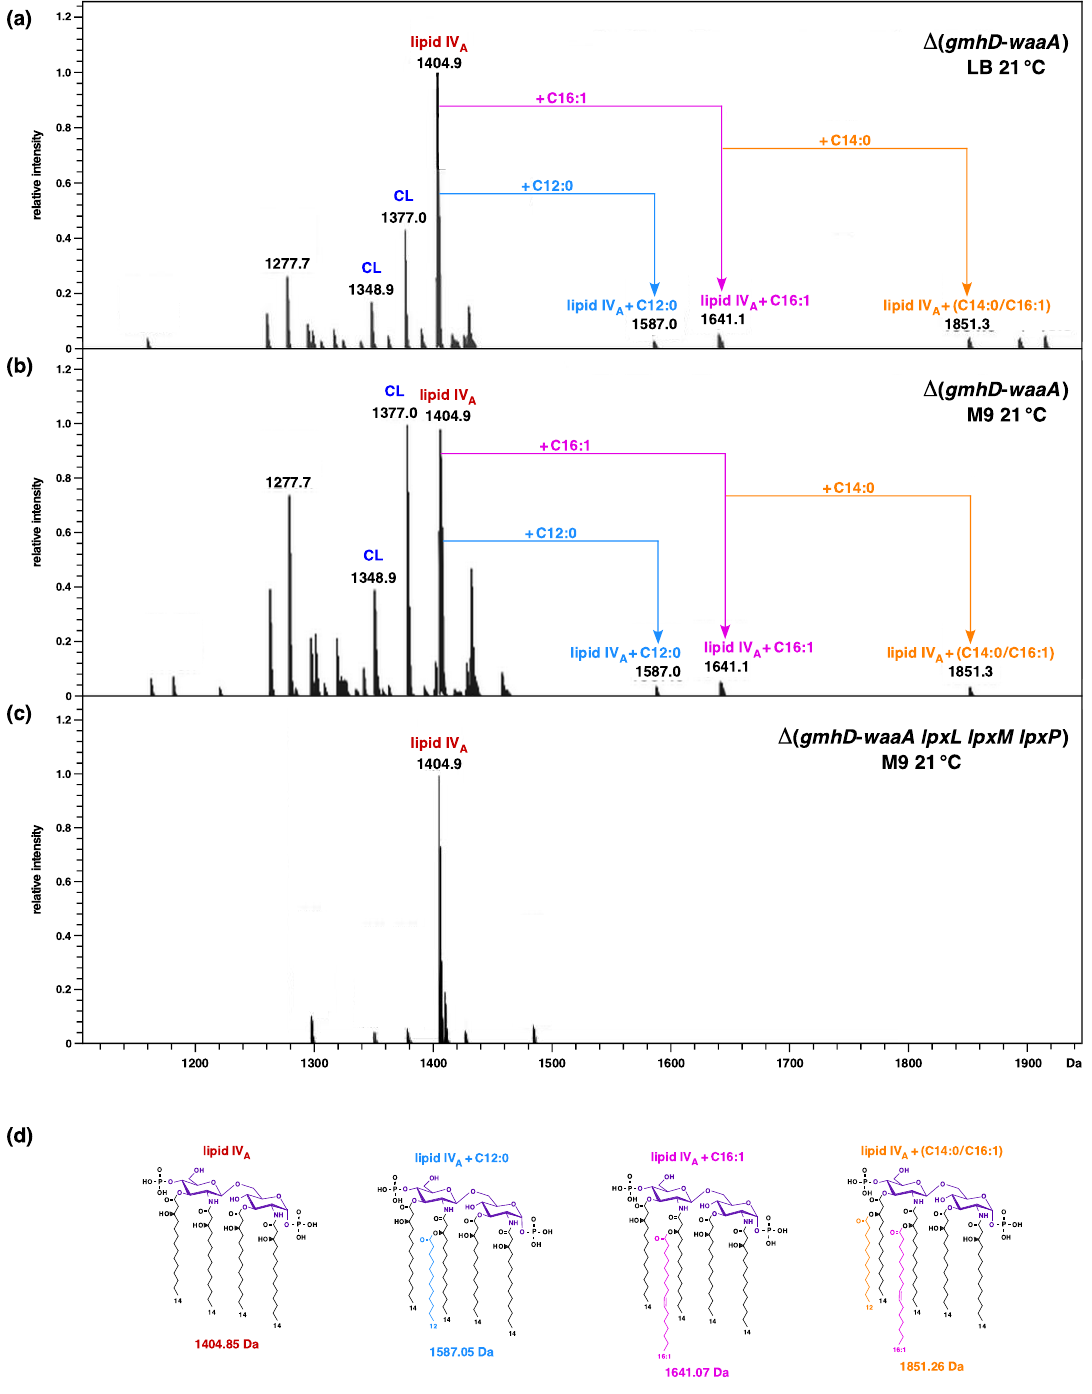
Figure 2. Charge deconvoluted ESI FT–ICR mass spectra in the negative ion mode of deletion derivatives of the whole waa locus, including WaaA Kdo transferase: ( a ) Mass spectra of LPS obtained from the Δ( gmhD–waaA ) strain grown in LB medium at 21 °C and ( b ) in M9 minimal medium. ( c ) Mass spectra of LPS obtained from the Δ( gmhD–waaA lpxL lpxM lpxP ) derivative grown in M9 medium at 21 °C. Mass peaks corresponding to the addition of lauroyl, myristoyl, and palmitoleate to the lipid IV A species are indicated. Mass numbers are monoisotopic masses of main peaks. Mass peaks corresponding to substitutions by phosphate or sodium adducts are not labeled. Molecular ions at 1348.9 u in panels ( a , b ) corresponding to cardiolipin and the ion at 1377 Da can either arise due to variation in acyl chain length, or can be a cardiolipin. ( d ) The chemical structure of various tetraacylated lipid IV A derivatives with predicted mass